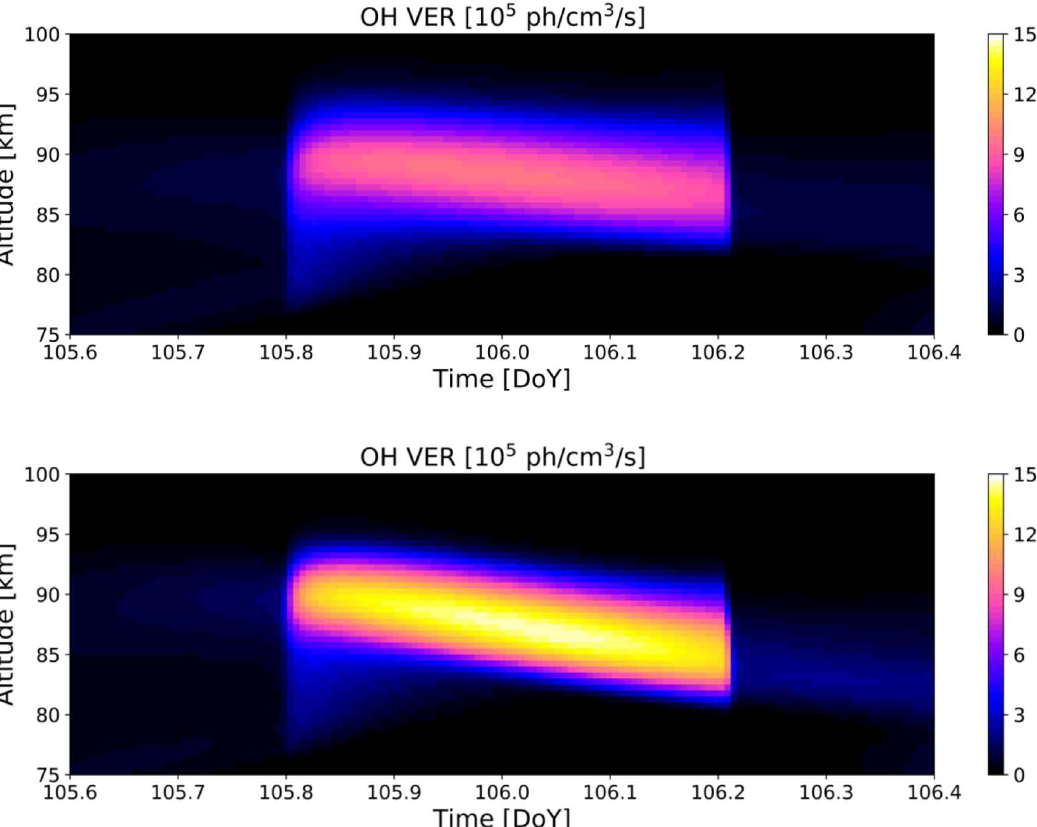
Fig. 4. Top panel: example of the OH volume emission rate (in 10 5 ph/cm 3 /s) between 80 km and 95 km for one night (starting at day of year [DoY] 105.8 and ending at DoY 106.2). Bottom panel: same example but with the tidal amplitude